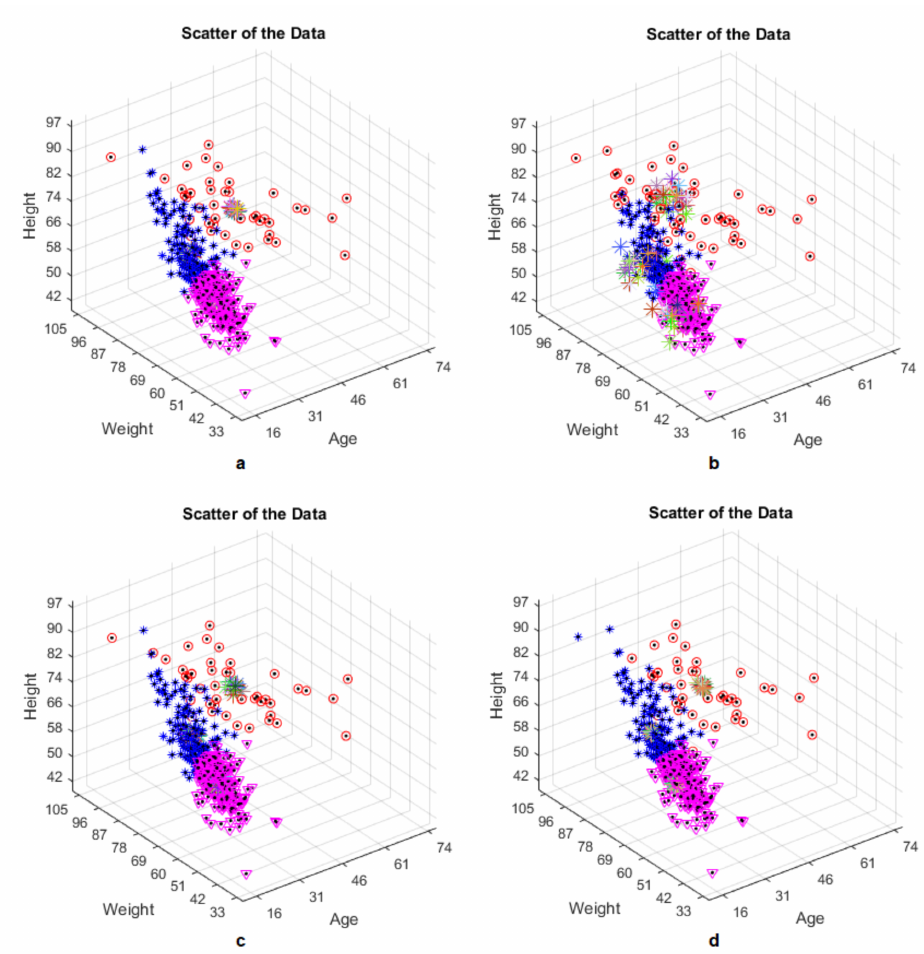
Figure 6. One of the cluster results for: ( a ) right tibial external rotation (RTER); ( b ) right tibial internal rotation (RTIR); ( c ) left tibial external rotation (LTER); ( d ) left tibial internal rotation (LTIR)